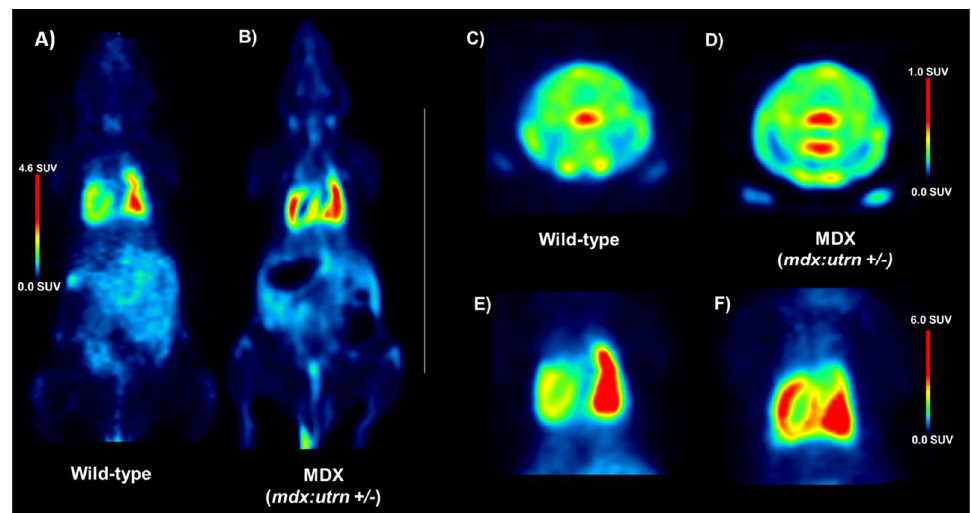
Figure 3. [ 18 F]FEPPA SUV images of representative 8–10 week wild-type (A,C,E) and age-matched MDX dystrophy (B,D,F) mice . Coronal whole-body ( A , B ), axial whole brain slices ( C , D ), and heart images ( E , F ) were generated from PET time-activity curves at 30–60 min ( n = 4–6 mice/genotype). MDX = dystrophin-deficient mdx:utrn (+/−) mouse model, SUV = standardized uptake values.